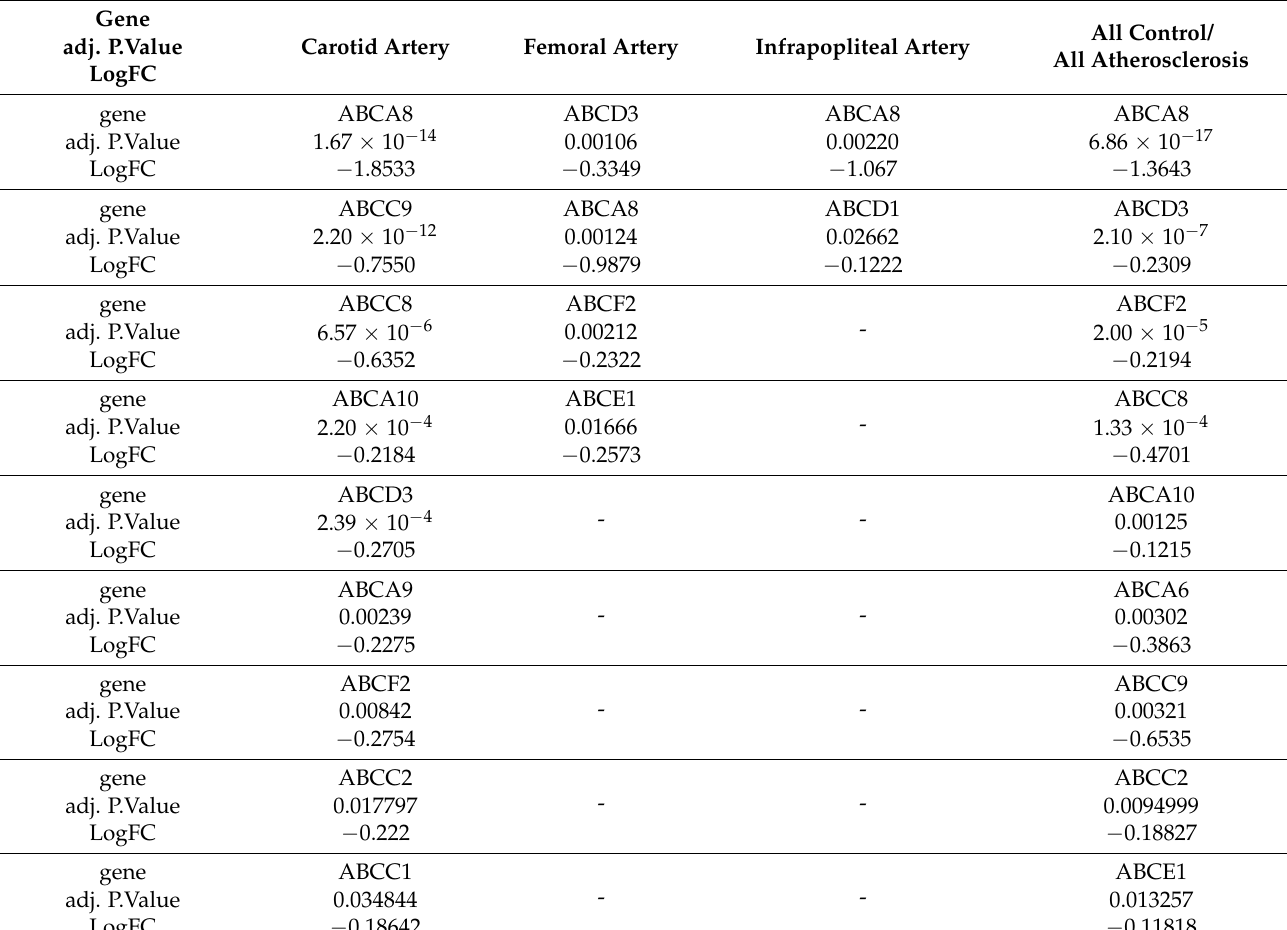
Table 2. The first downregulated ABC genes, ranked by p values adjusted using the algorithm of Benjamini–Hochberg (adj. P.